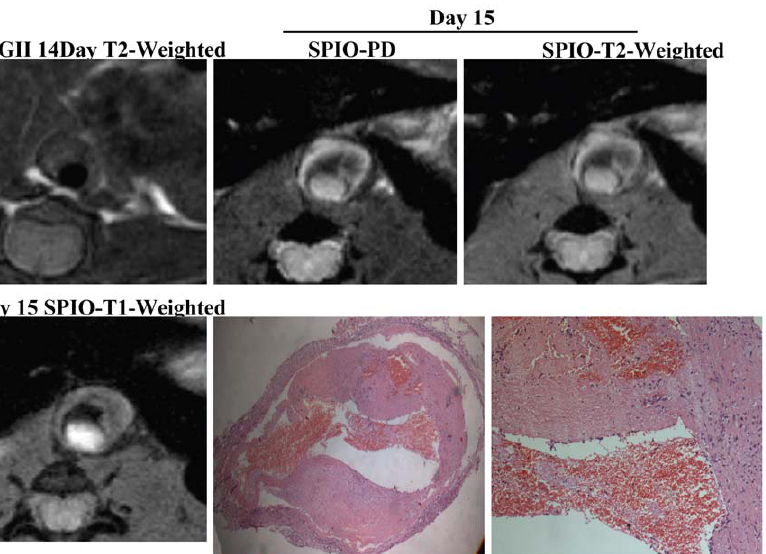
Figure 5. Acute thrombus formation. Compared with 14 days of ANG II infusion, MRI at day 15 showed acute artery occlusive and mural thrombi (red arrow hyperintense on T1-weighted images). HE showed fresh thrombus with platelets, inflammatory cells, and fibrin mesh.